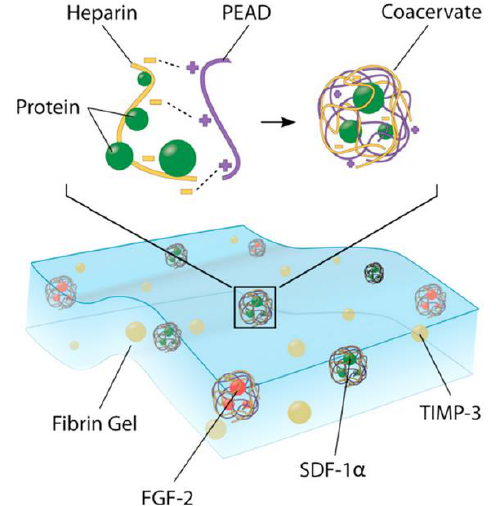
Figure 9. Fibrin hydrogels with protein-loaded coacervates. Reprinted from [114], copyright 2021, with permission from Elsevier.